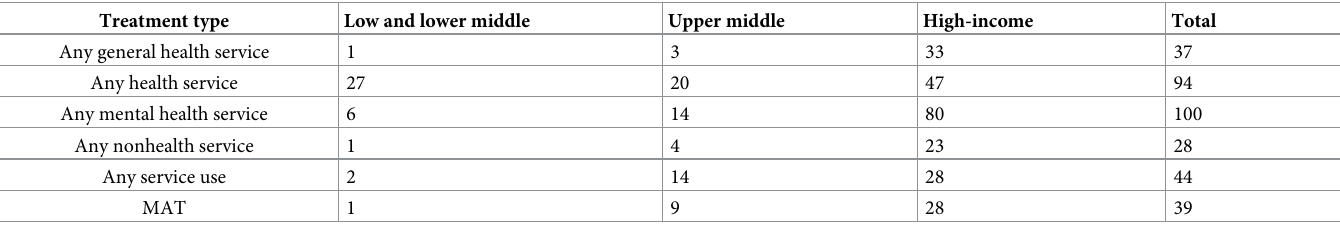
Table 3. Number of datapoints for MDD by treatment type and income group. Treatment